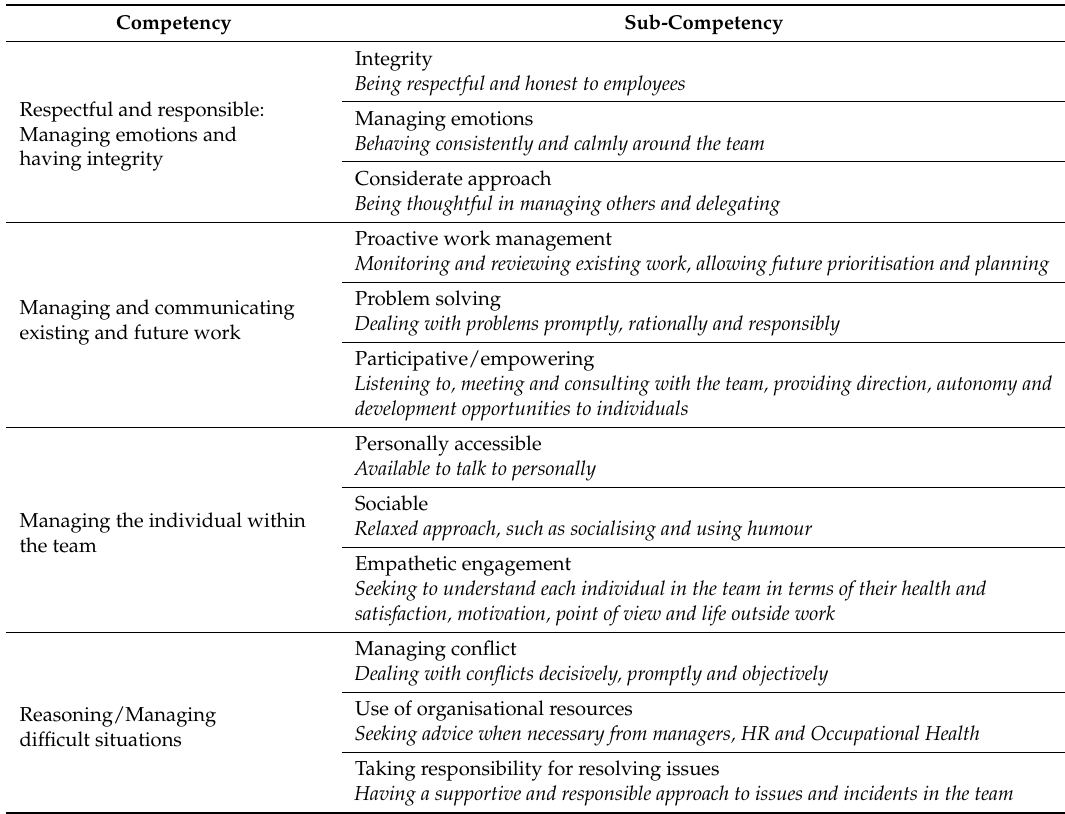
Table 1. Behaviors that prevent or reduce stress at